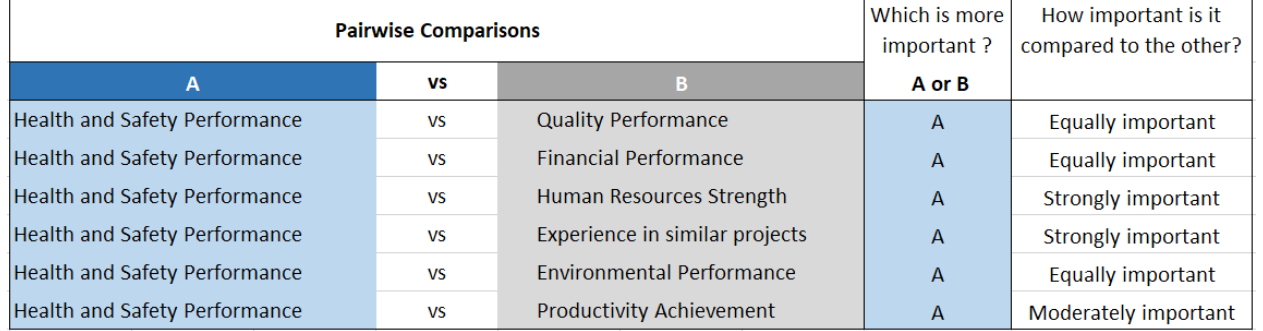
Table 6. Pairwise comparison matrix of expert E2. HS.MoP